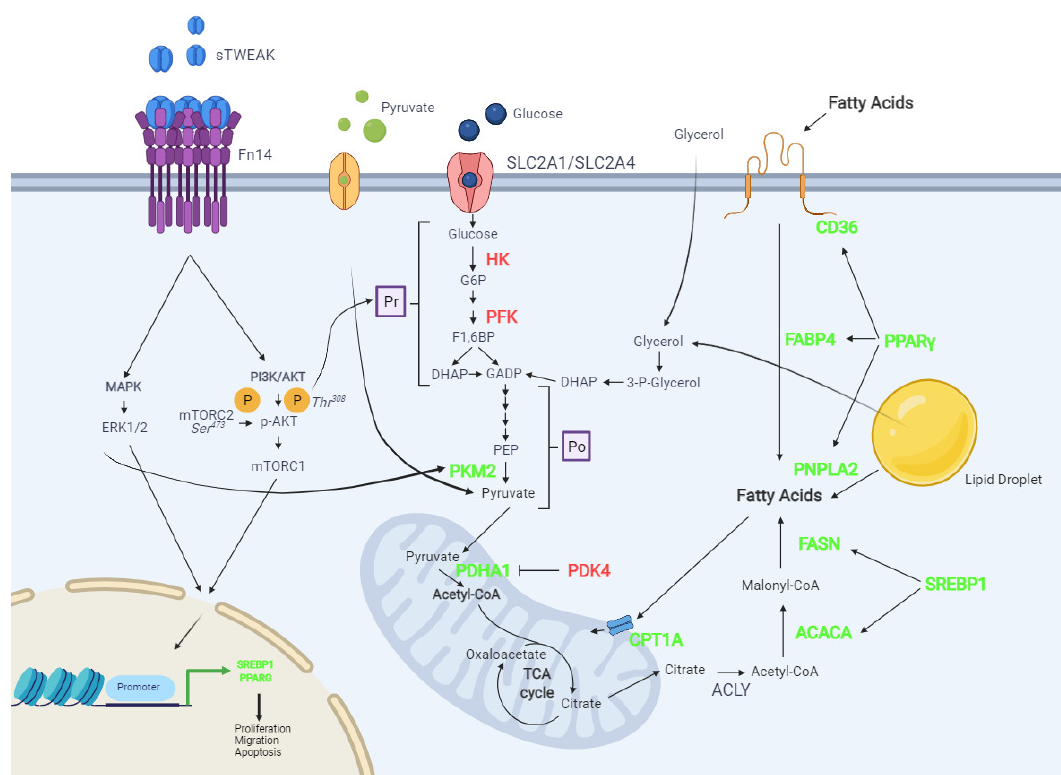
Figure 6. A scheme depicting the possible effects of the TWEAK/Fn14 axis on lipid and glucose metabolic pathways in PCa cells. TWEAK/Fn14 engagement phosphorylates AKT in ser473. PI3K-AKT-mTORC1 signaling is a key factor in controlling lipid and glucose metabolism. pAKT can regulate SREBP1 translocation to the nucleus, increasing ACLY, ACACA and FASN expression, potentiating de novo lipogenesis. AKT phosphorylation can also regulate PPARG, thus increasing the expression of the lipase PNPLA2, which catalyzes the breakdown of the ester bonds of fatty acids and activates lipolysis. Lipid entry and transport is also upregulated by PPARG through CD36 and FABP4 expression. CPT1A upregulation by sTWEAK would indicate that lipid oxidation in the mitochondria is boosted. De novo lipogenesis begins with citrate, which is generated by the conversion of pyruvate to acetyl-CoA mediated by an increase in the expression of PDHA1 and a decrease in PDK4 inhibitor expression, both actions regulated by sTWEAK/Fn14 engagement. Phosphorylation of ERK1/2 by sTWEAK/Fn14 engagement can regulate SREBP1 and PPARG and can also increase intracellular pyruvate concentrations by phosphorylating PKM2 and increasing its expression. The preliminary phase of glycolysis might be reduced, since HK and PFK expression is downregulated. Exogenous pyruvate can also be taken up. Glycerol may be an alternative source for pyruvate. Color pattern: green color represents upregulated genes and red downregulated genes; Created with BioRender.com. Abbreviations: PI3K, Phosphoinositide 3-kinase; AKT, protein kinase B; p-AKT, phosphorylated protein kinase B; MAPK, mitogen-activated protein kinase; ERK, extracellular signal-regulated kinase; TF, transcription factor; SLC2A1, glucose transporter 1, SLC2A4, glucose transporter 4; Pr, preparatory phase; HK, hexokinase; PFK, Phosphofructokinase; G6P, Glucose 6-phosphate; F1,6BP, Fructose-1,6-Biphosphate; DHAP, Dihydroxyacetone phosphate; GADP, glyceraldehyde-3-phosphate; Po, Payoff phase; PEP, phosphoenolpyruvate; PKM2, Pyruvate kinase 2; PDHA1, Pyruvate dehydrogenase; PDK4, Pyruvate dehydrogenase lipoamide kinase isozyme 4; TCA, tricarboxylic acid; ACLY, ATP citrate synthase; ACACA, Acetyl-CoA Carboxylase Alpha; SREBP1, Sterol regulatory element-binding transcription factor 1; FASN, Fatty acid synthase; PNPLA2, patatin-like phospholipase 2; PPAR γ , Peroxisome proliferator-activated receptor gamma; FABP4, fatty acid-binding protein 4; CD36, cluster of differentiation 36; CPT1A, Carnitine palmitoyltransferase IA; 3-P-Glycerol,